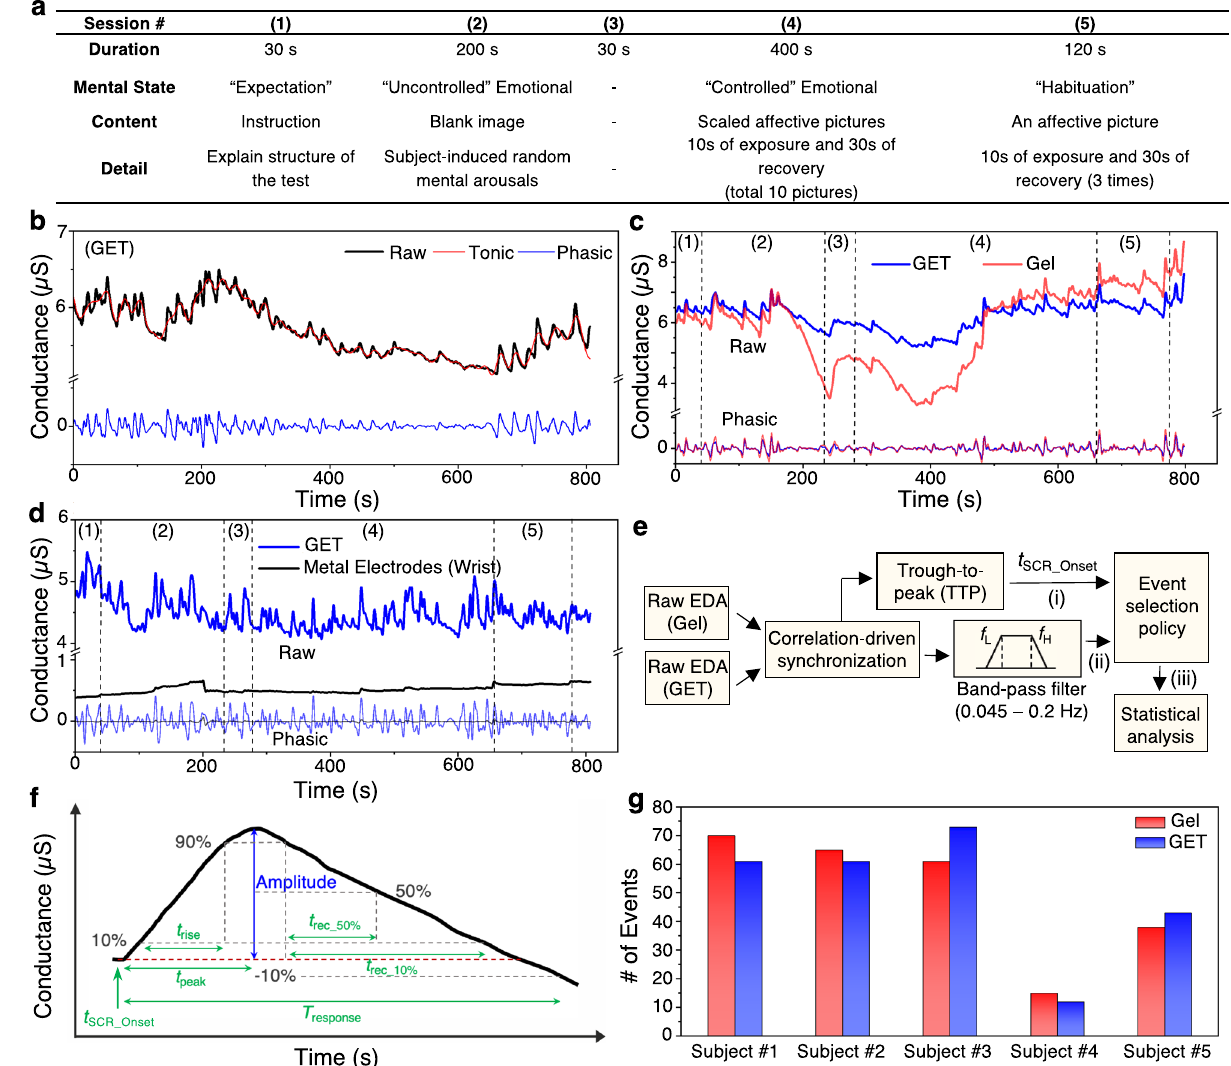
d ComparisonofEDAmeasuredbyGETonthepalm(blue)vs.drymetalelectrodes on the wrist (black). e SCR detection algorithm for the correlation analysis. f Parameters of an EDA signal used in the statistical analysis to validate the corre- lationbetweenGETandgelmeasuredEDA. g Thetotalnumberofeventsmeasured by GET (blue) and gel electrodes (red) on fi ve different